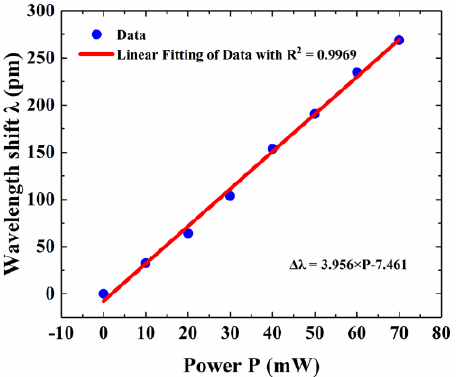
Figure 6. Resonant wavelength shift caused by coupling-condition tuning.